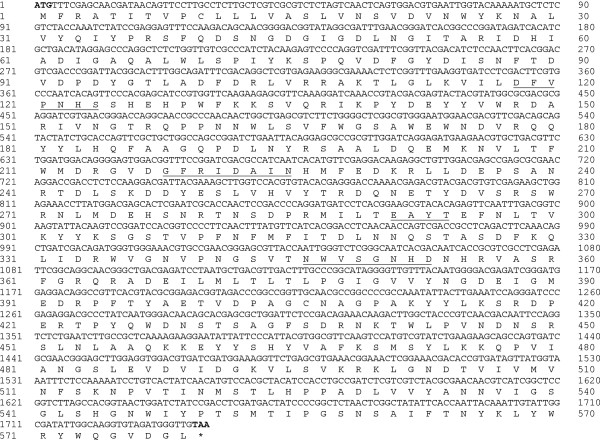
The full-length AciHBGase II cDNA and deduced amino acid sequence of the encoded AciHBGase II enzyme. The predicted start (ATG) and stop (TAA) codons are shown in bold, giving a predicted open reading frame (ORF) of 1,740 bp encoding for a deduced 579 residue amino acid sequence. The conserved amino acid regions associated with the α-amylase family are underlined.